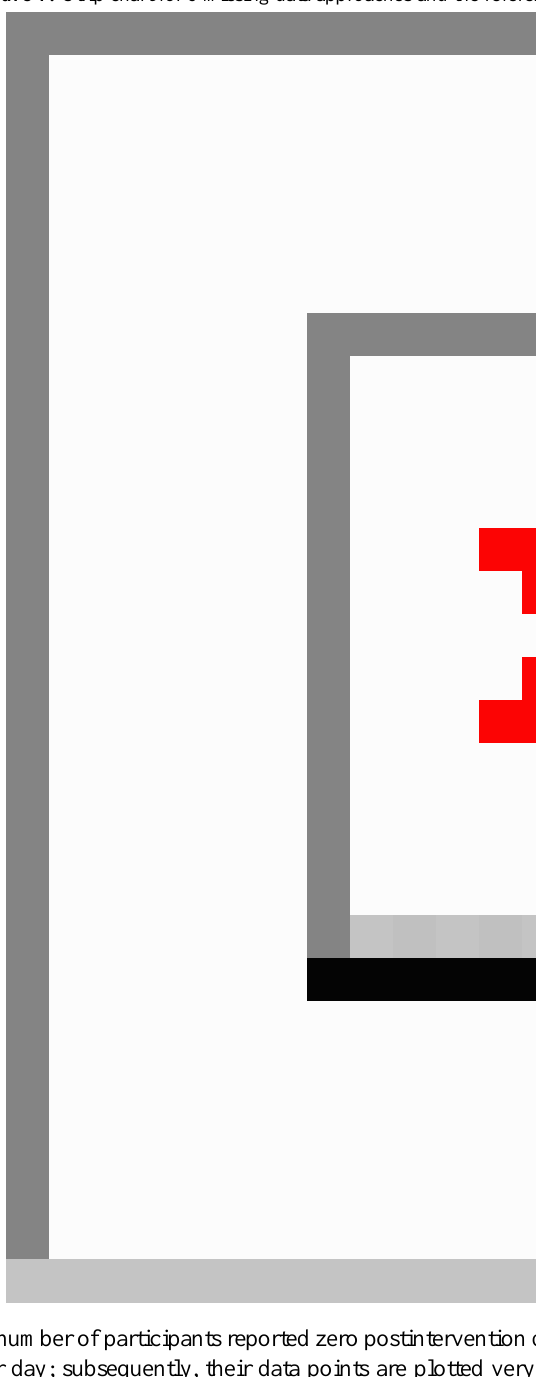
Figure 1. Strip chart for 9 missing data approaches and the reference